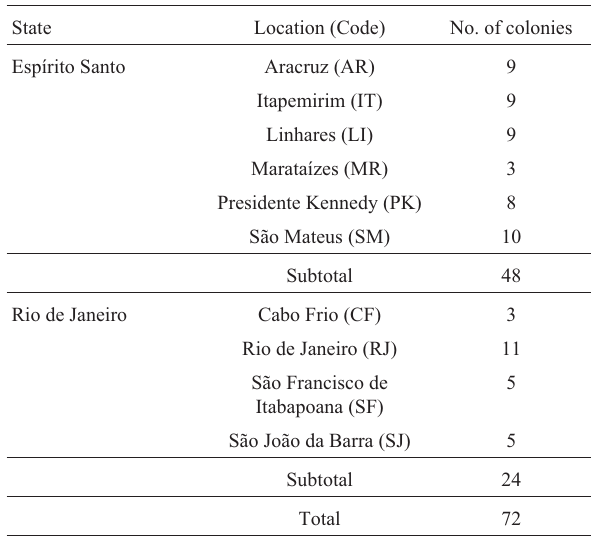
Table 1 - Locations sampled and the number of A. robusta colonies ana- lyzed in this study. State Location (Code)